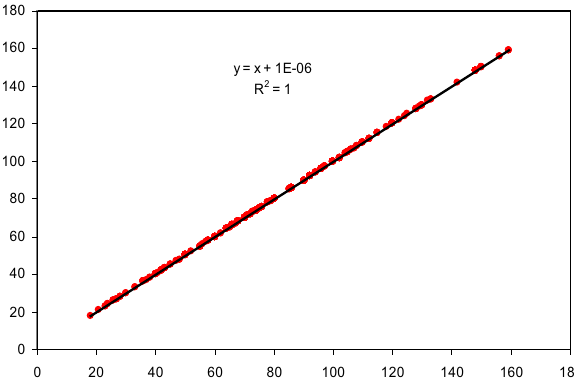
Fig. 12 Actual versus predicted choke size for FL model testing (Radii =